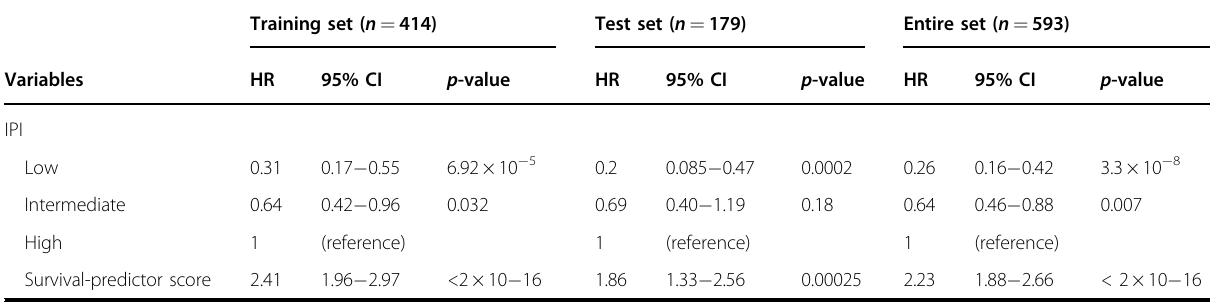
Table 1 Multivariate Cox regression analysis with the gene expression-based predictor score and the IPI for the overall survival of DLBCL